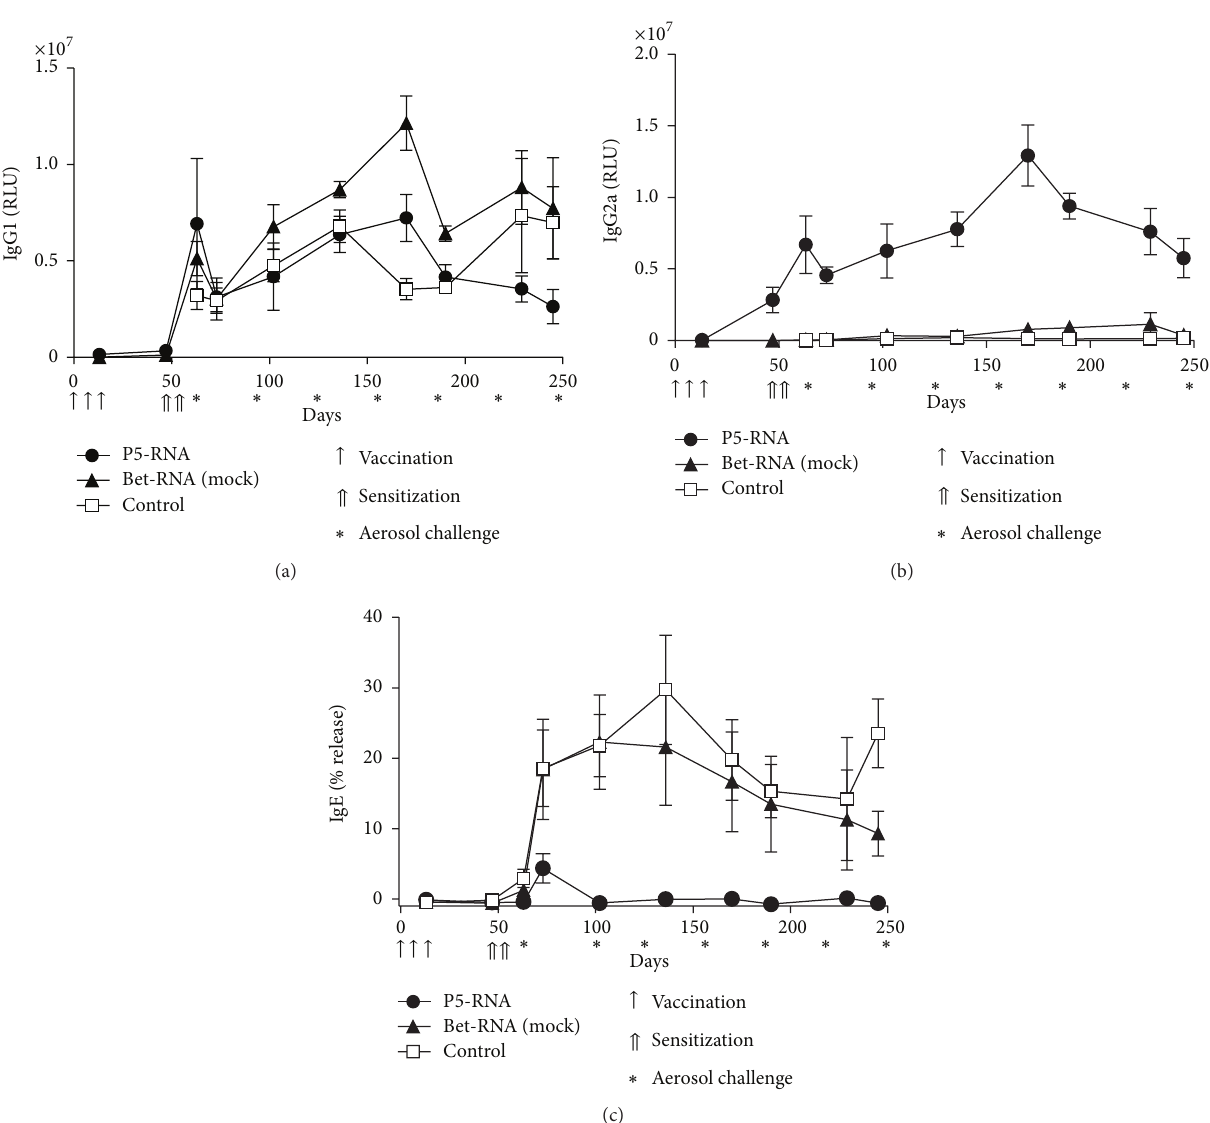
Figure 4: Time course of Phl p 5-specific IgG1 (a), IgG2a (b), and IgE (c) antibody levels as measured by a luminometric ELISA or RBL assay, respectively. BALB/c mice were prevaccinated and sensitized one month later, followed by monthly exposure to aerosolized rPhl p 5. Data are displayed as means ± SEM ( 𝑛 = 5